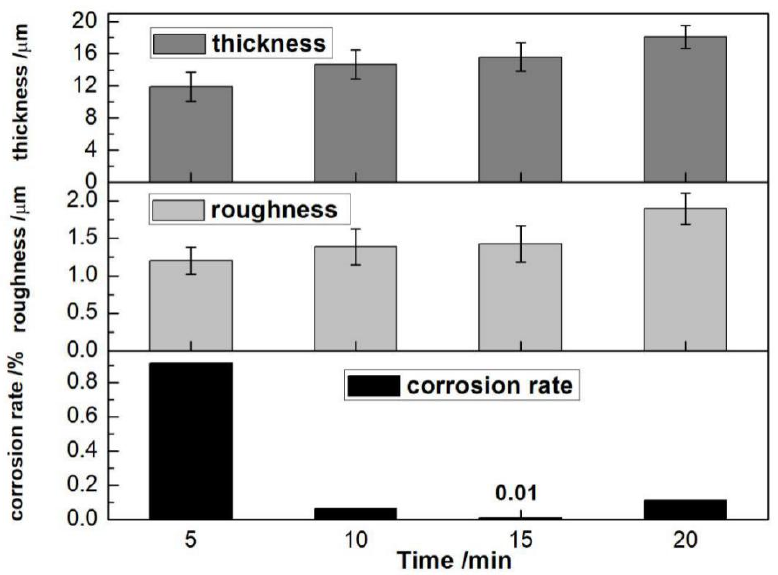
Figure 6. The values of corrosion rate, roughness and thickness at different oxidation time. Electrolyte compositions: 45 g/L NaOH, 50 g/L Na 2 SiO 3 , 90 g/L Na 2 B 4 O 7 . Electrical parameters: current density 1 A/dm 2 ; pulse frequency 100 Hz; duty cycle 10%.